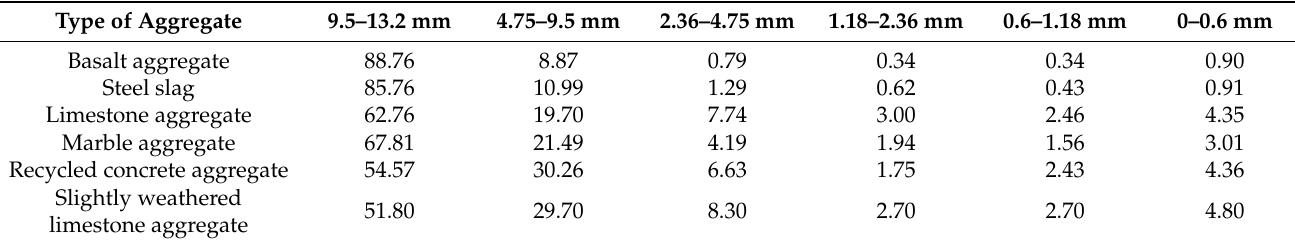
Table 9. Aggregate particle distribution after gyratory compaction.